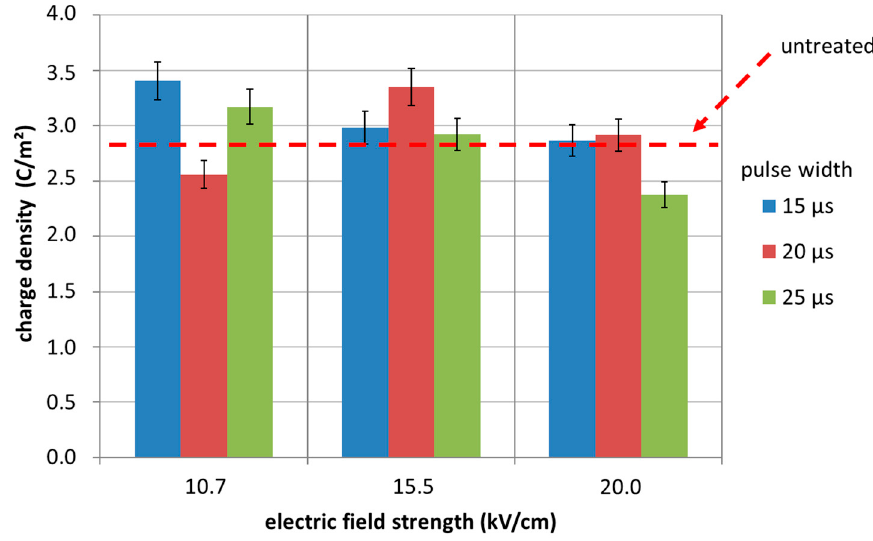
Figure 5. Modification of charge density of CM after PEF application with different pulse widths (15–25 μ s) and electric field strengths (10.7–20 kV/cm), applying a specific energy of 25 kJ/kg and an inlet temperature of 10 °C, compared to the values of an untreated CM sample (dashed line).